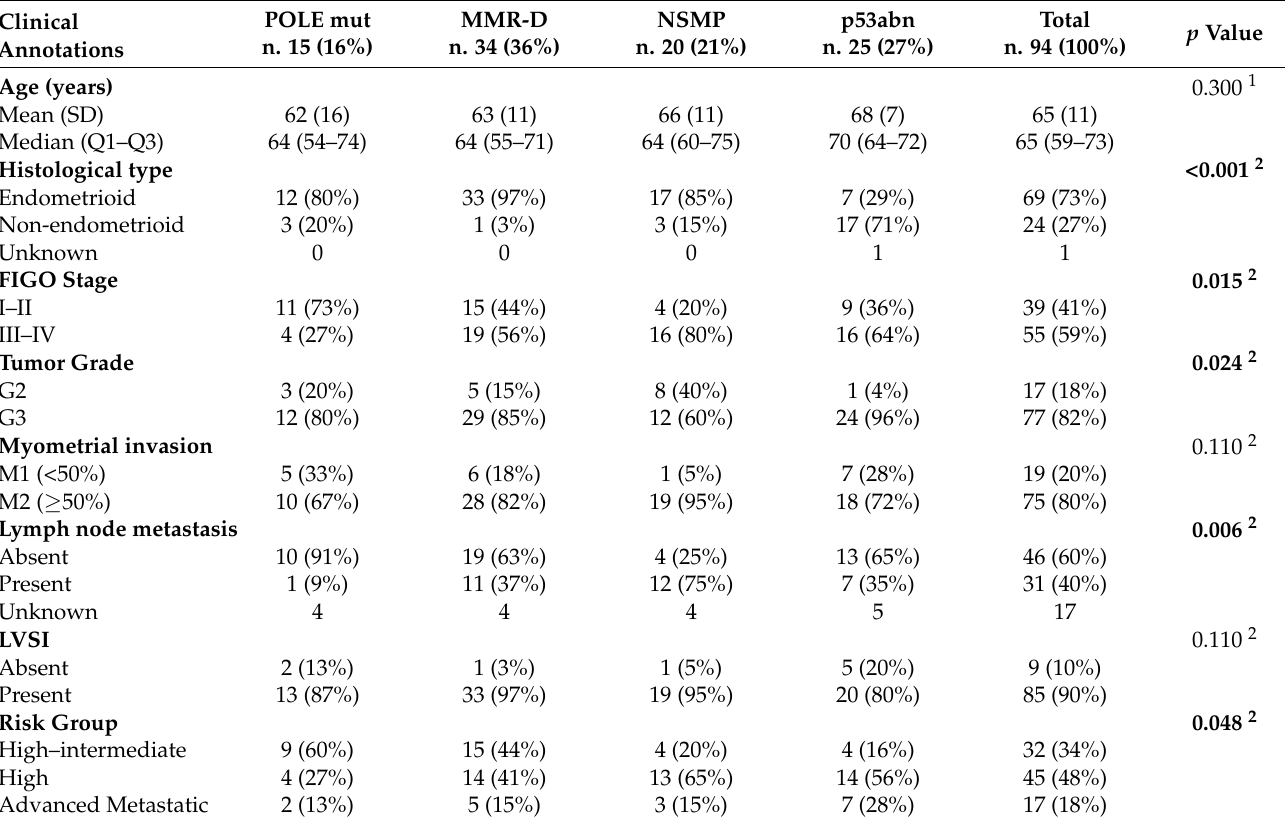
Table 1. Association between molecular subtypes and clinicopathological characteristics of the Brescia